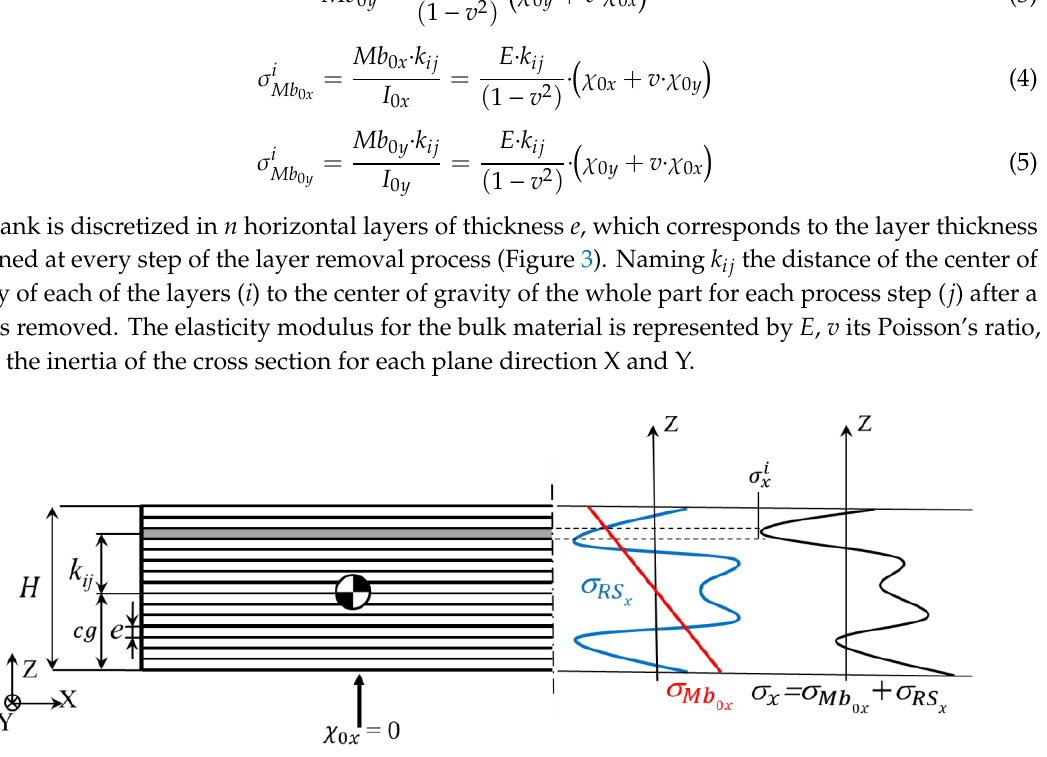
Figure 3. Discretization of the section in n layers of thickness e and stress acting in the cross section X when the raw part is clamped.